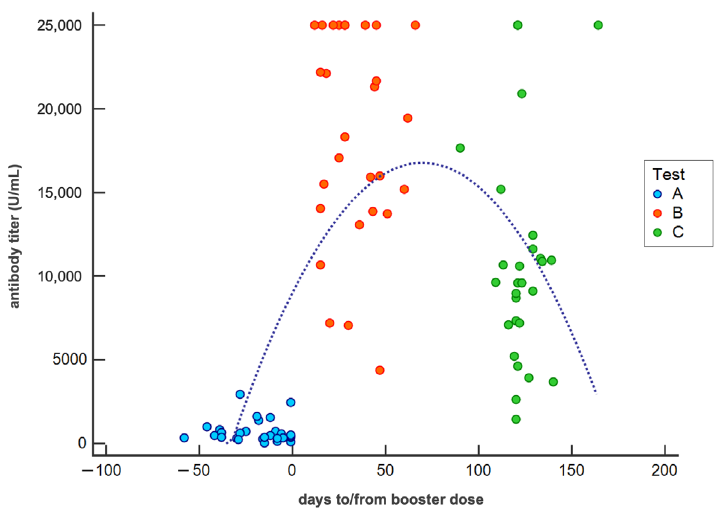
Figure 2. Scatter diagram showing the antibody titer (detection limits 0.4–25,000 U/mL) of each naïve subject measured in tests A, B, and C against time and related regression curve. (Test A: prior booster; Test B: one month after booster; Test C: four months after booster).